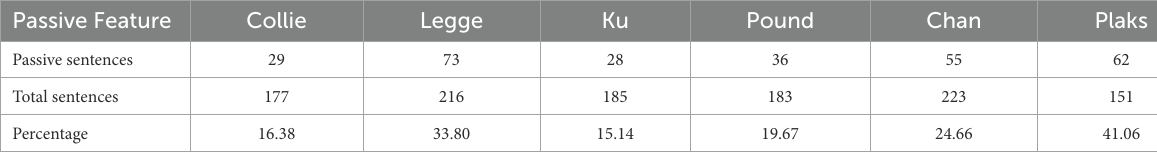
TABLE 8 Passive sentence statistics of the six TTs. Passive Feature